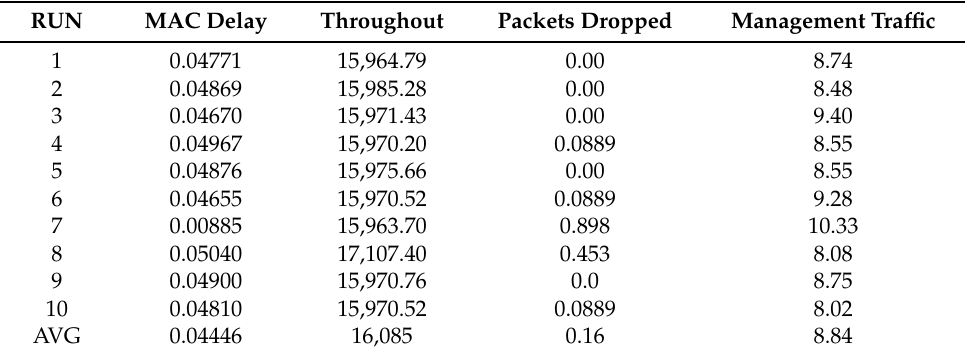
Table 2. Simple Scenario Tabu